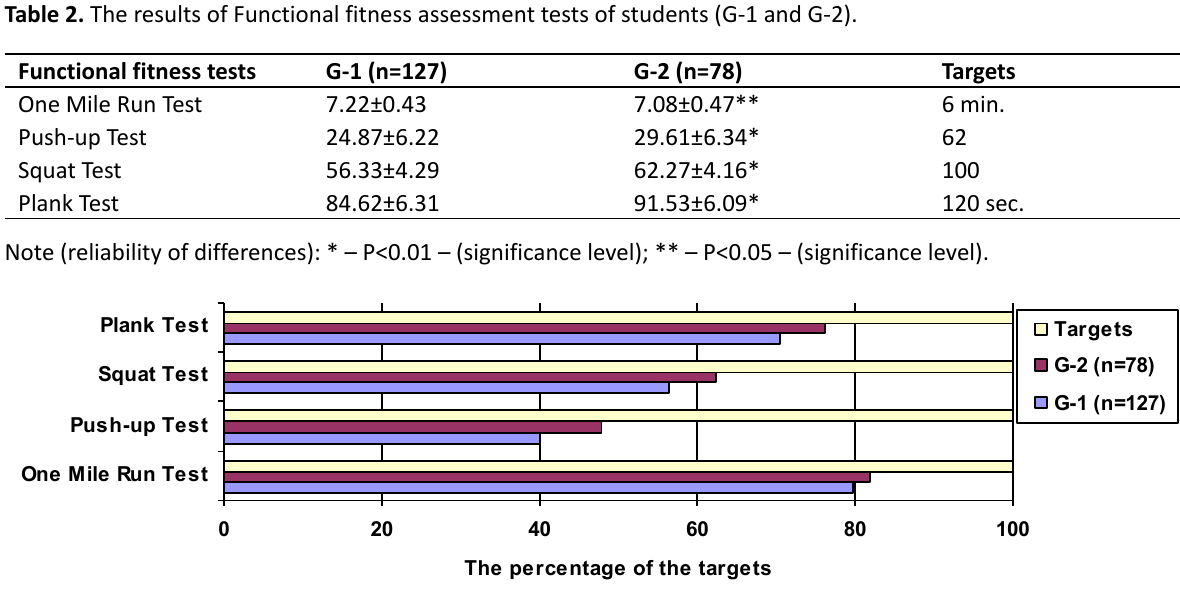
Fig. 3. The data on performance of functional fitness